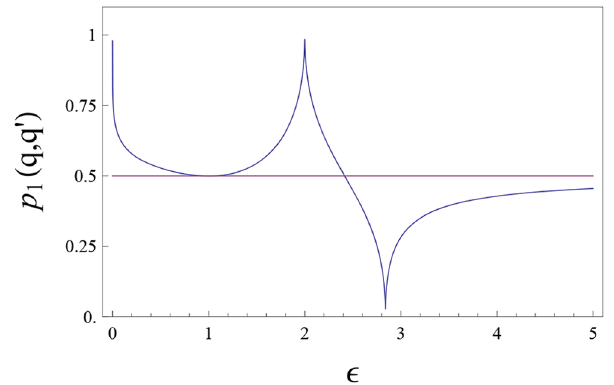
Figure 7. Order of presentation effect in the boomerang regime. The same as in Fig. 4 but for E ~ 1 : 5 (boomerang regime). Now the final opinion of P is inclined to the first opinion (that of Q ) with respect to the distance. The initial maximally probable opinion of P is still maximally probable. Moreover, its probability has increased and the width around it has decreased. The final opinion has 3 peaks.